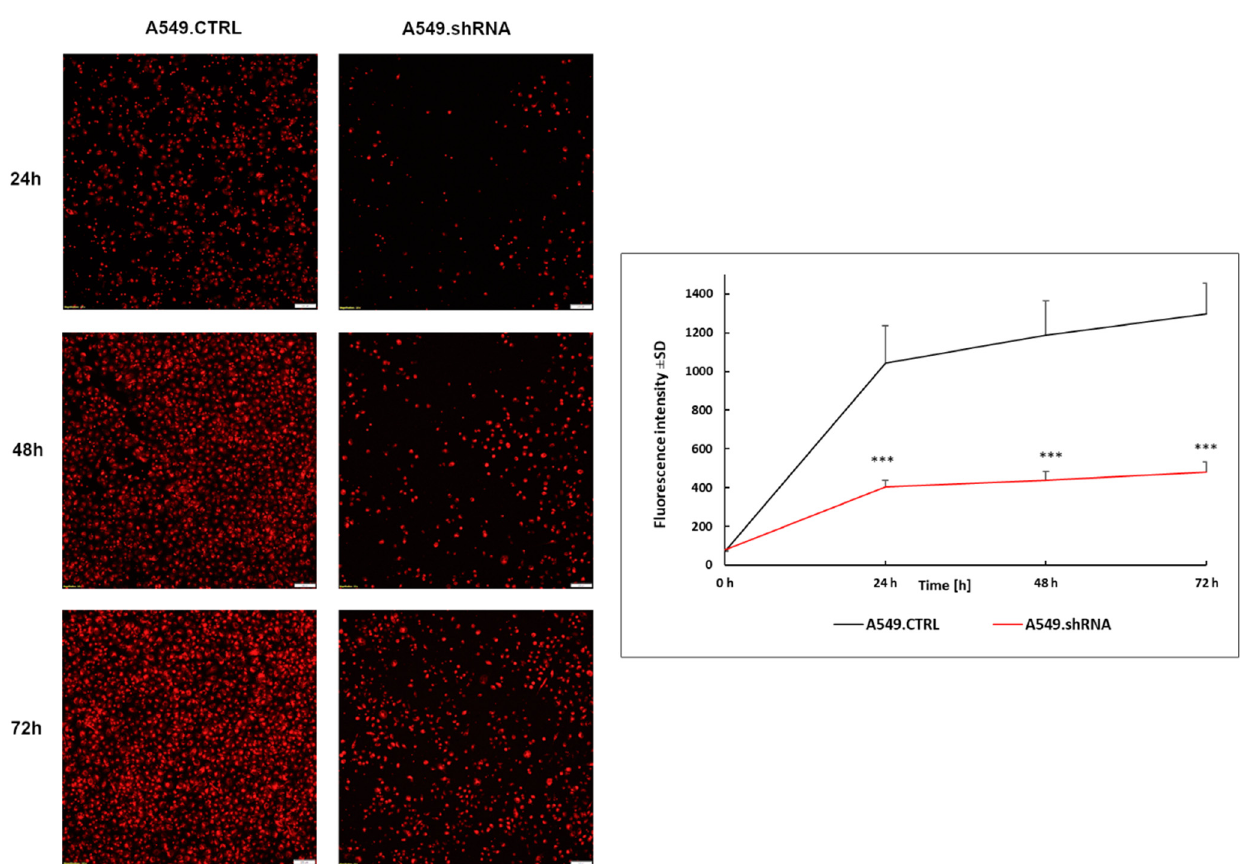
Figure 10. Silencing of periostin (POSTN) affects the invasiveness of lung cancer cell lines. Reduced invasion through the Matrigel matrix was observed in fluorescently labeled A549.shRNA cells compared to A549.CTRL cells. Data are presented as mean ± SD. Bonferroni multiple comparison test, *** p < 0.001. Magnification 10×. Bar = 100 µm.